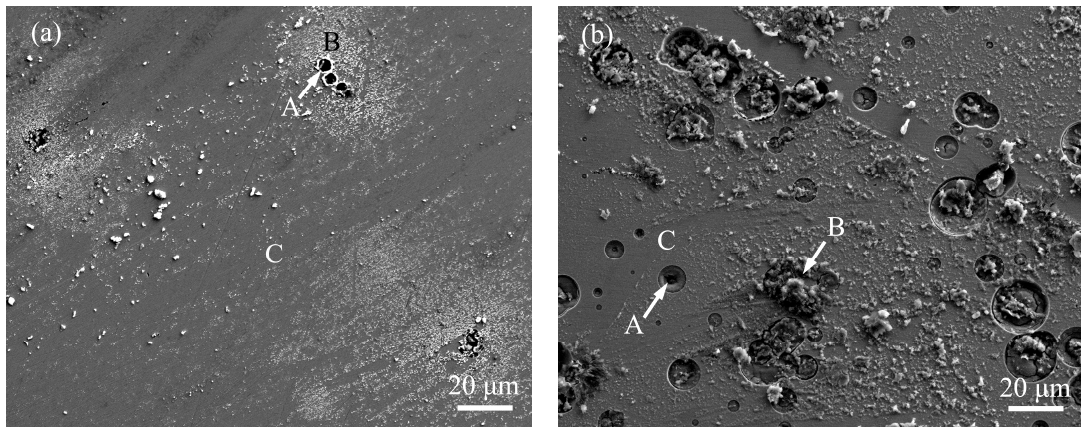
Figure 8. SEM images of the corroded surfaces for the Zr 70 Cu 12.5 Ni 10 Al 7.5 ( a ); and Zr 65 Cu 12.5 Ni 10 Al 7.5 Ag 5 ( b ) alloys after polarization. Table 3. Compositions in the pit (A), corrosion product (B) and passive film (C) by EDS for the